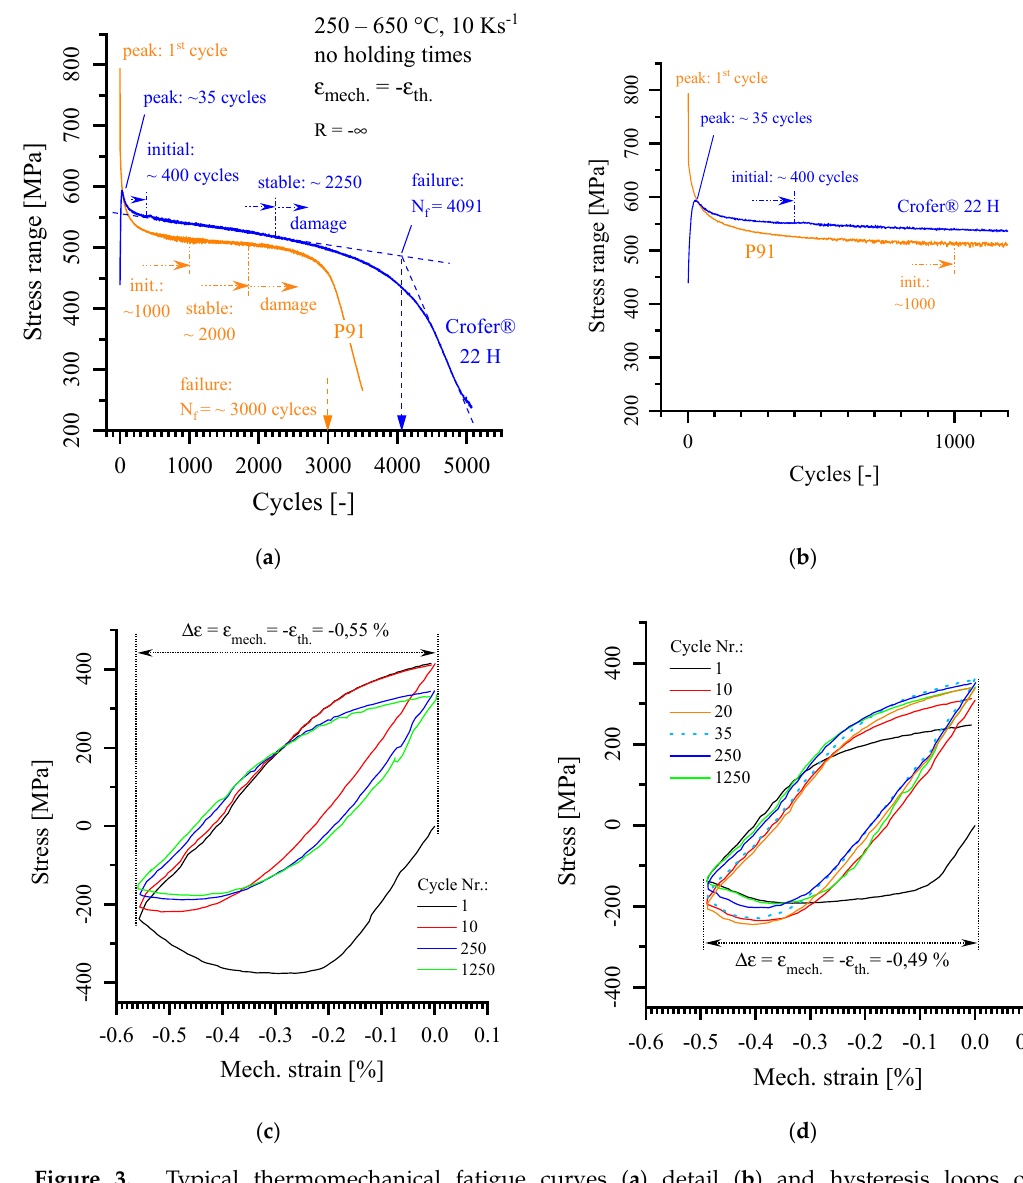
Figure 3. Typical thermomechanical fatigue curves ( a ) detail ( b ) and hysteresis loops of ferritic- martensitic ( c ) and ferritic Crofer ® 22 H steel ( d ). ferritic-martensitic ( c ) and ferritic Crofer ® 22 H steel ( d ).